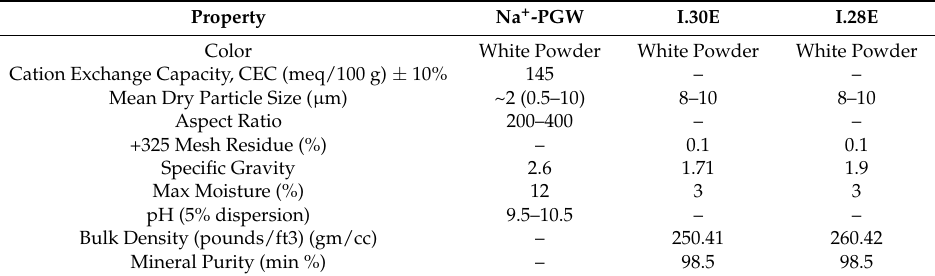
Table 2. Physical properties of Nanocor Inc. montmorillonite